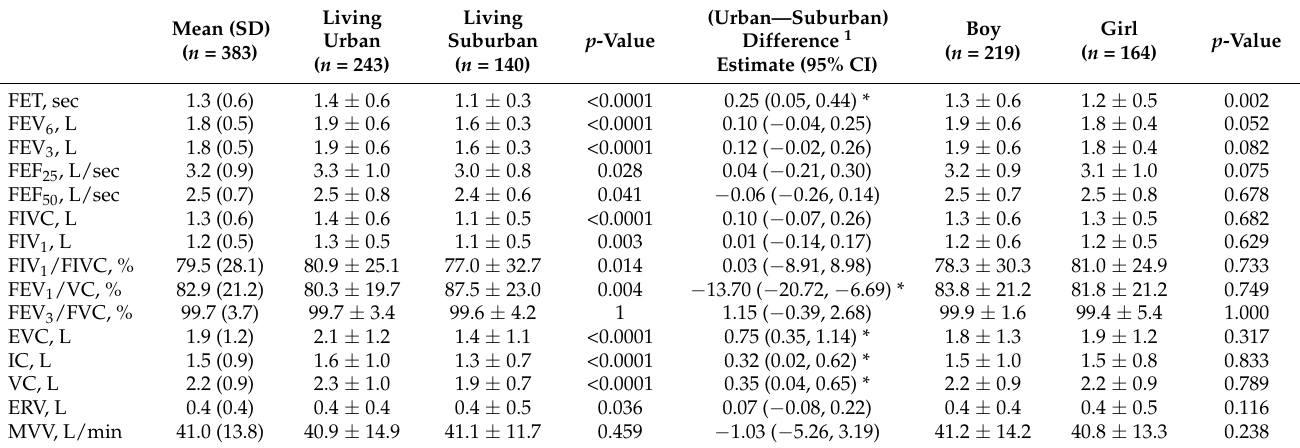
Table 2. Children’s lung function by sex and residential location.